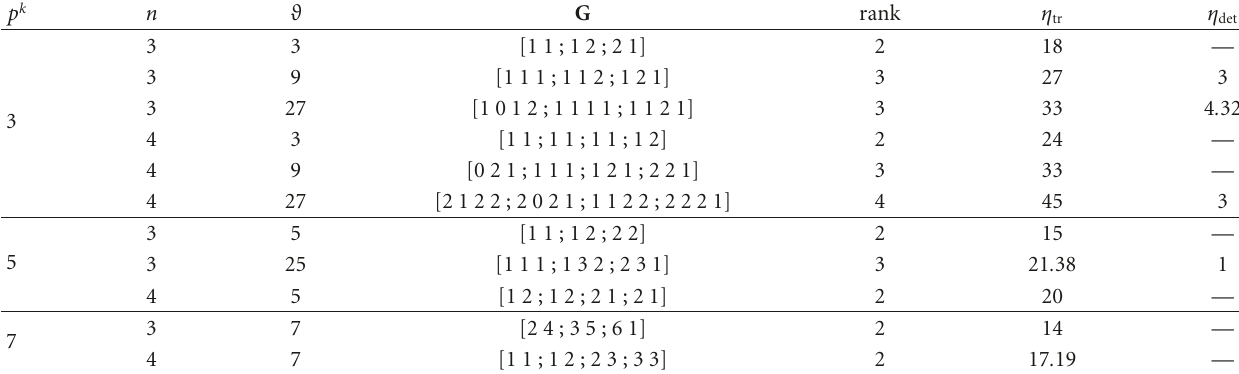
Table 1: New good STCCs over finite fields based on the trace